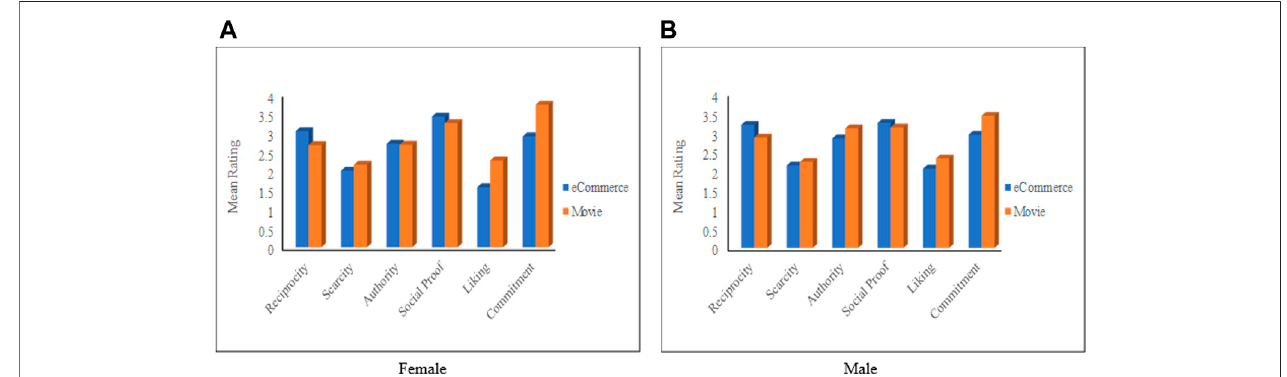
FIGURE 7 | Mean rating based on gender for both application domains. (A) Female, (B)